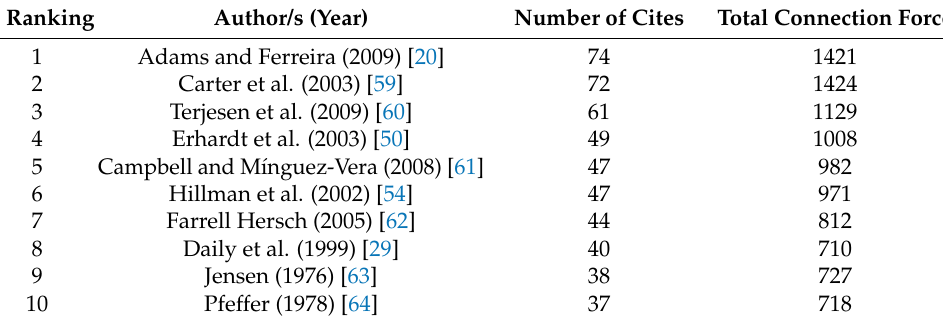
Table 3. Ranking of